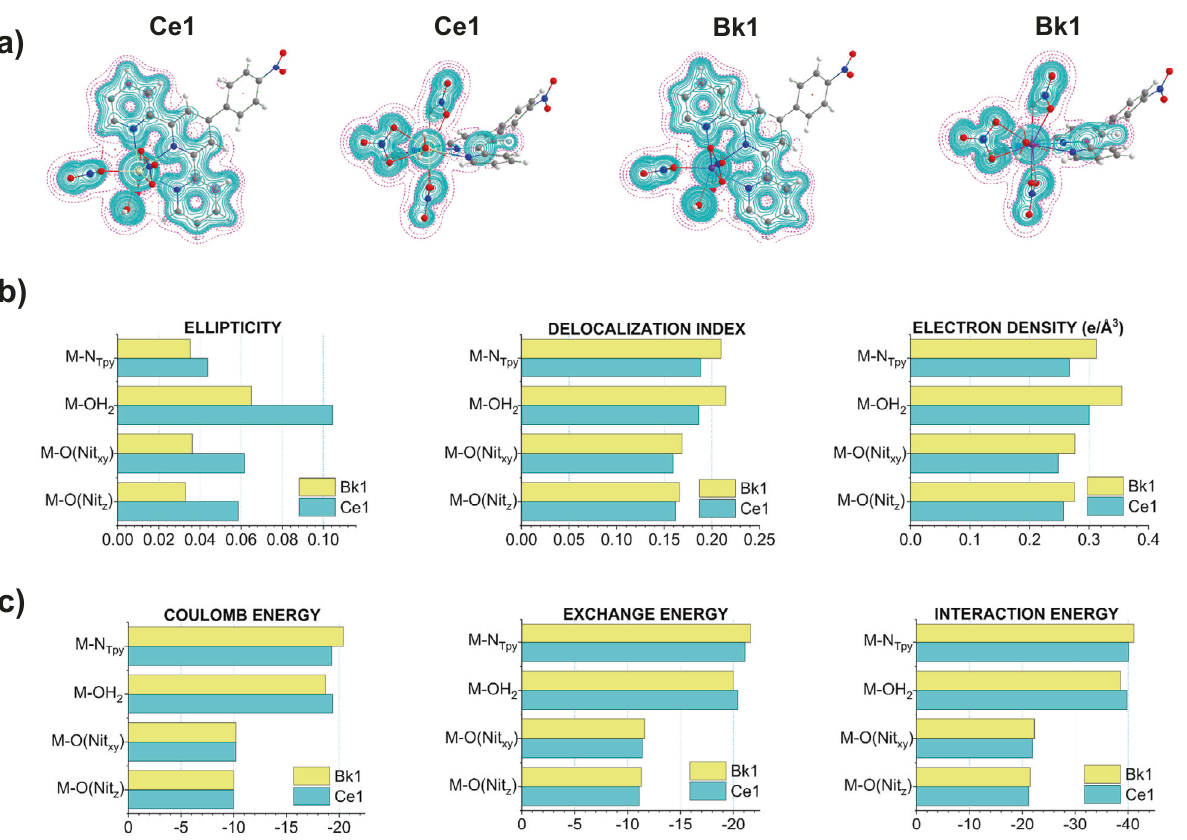
Fig. 5 Bonding features of the plane of covalency based on the CASSCF electron densities. a Plots of the total energy density, H ( r ), in the preferential plane of interaction for Ce1 (Ce = yellow sphere) and Bk1 (Bk = purple sphere) and perpendicular to this plane. The solid cyan lines denote the regions where H ( r ) is negative (covalent character), while pink dashed lines represent areas where H ( r ) is positive (purely ionic). The water molecule as well as the terpy* N atoms display covalent interactions with the metal centers in both Ce1 (cyan bars) and Bk1 (yellow bars) compared to the nitrate ligands. b QTAIM metrics for Ce1 and Bk1 ; the ellipticity describes the deviations from a cylindrical single bond as values differ from zero, while delocalization indices and electron densities describe the shared pairs of electrons and accumulation of electrons in the bond critical points, respectively. c Interacting quantum atom (IQA) energy decomposition analysis in kJ mol − 1 . The total energy of interaction is decomposed into Coulomb or electrostatic and exchange or covalent energy components. M – N terpy correspond to average metrics of the three metal – terpy* bonds; M – O(Nit xy ) and M – O(Nit z ) refer to metal – nitrate bonds in the plane (equatorial) and out of the plane (axial), respectively. Tables with detailed information of QTAIM and IQA can be found in the Supplementary